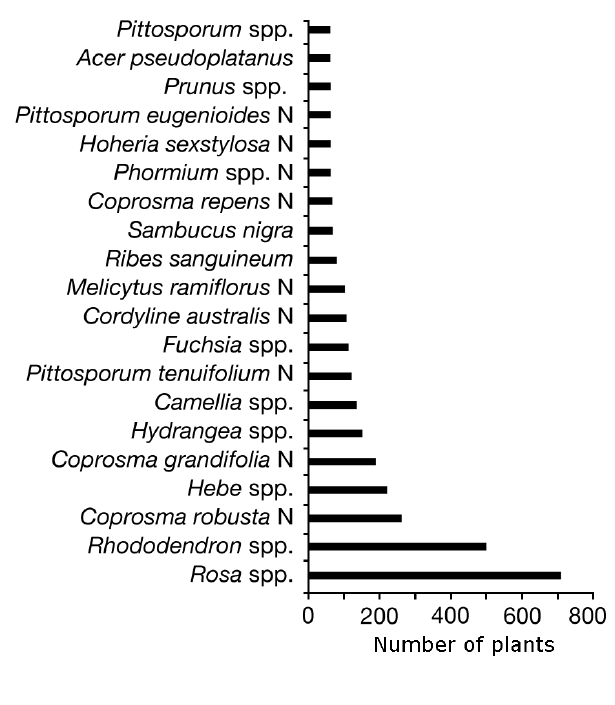
Fig. 1 . The 15 most abundant woody genera/species recorded across 55 gardens; N indicates